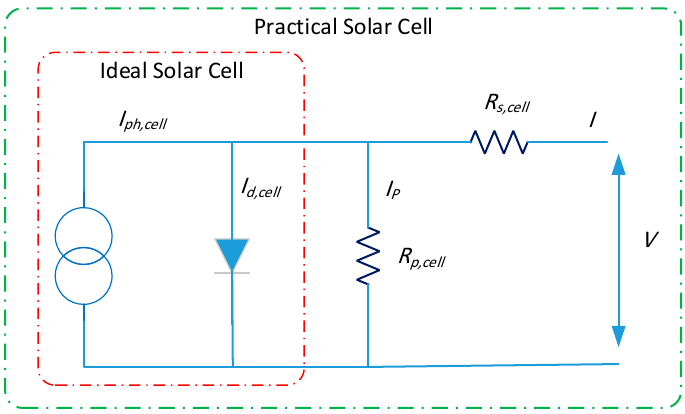
Figure 4. The equivalent circuit of photovoltaic cell.